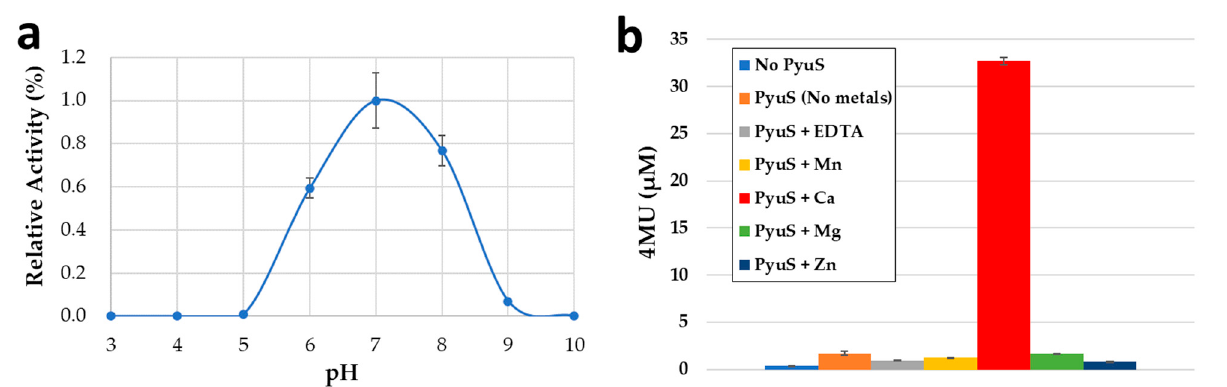
Figure 5. ( a ) The relative pH optima of PyuS as determined with sulfatase substrate 4MUS. ( b ) Activity of PyuS on 4MUS in the presence of the different metals. No PyuS, PyuS (No metals), and EDTA were used as controls. Error bars represent biological replicates.